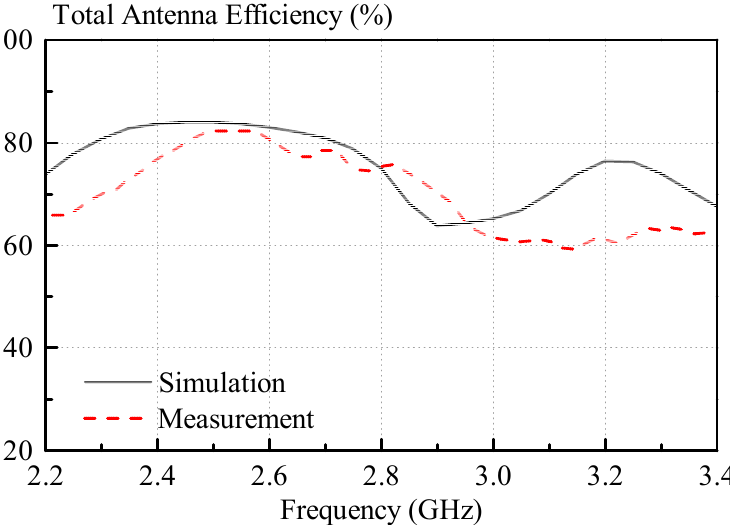
Figure 16. Measured and simulated total antenna efficiencies, including the mismatch of the anten ‐ nas.